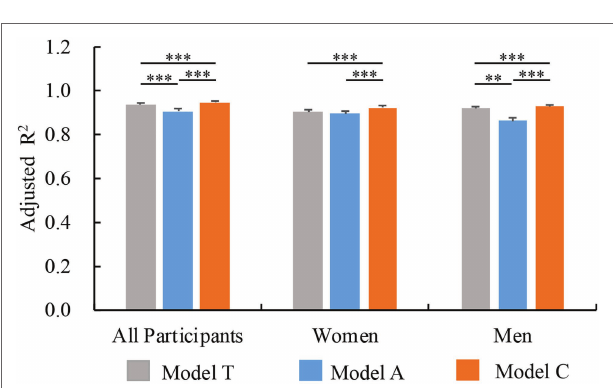
FIGURE 7 | Performance of three regression models [typicality (Model T), attractiveness (Model A), and typicality and attractiveness combined (Model C)] of trustworthiness judgments based on all faces ( n = 281) across all participants, women only, and men only. ∗∗ p < 0.01; ∗∗∗ p < 0.001. Error bars represent standard